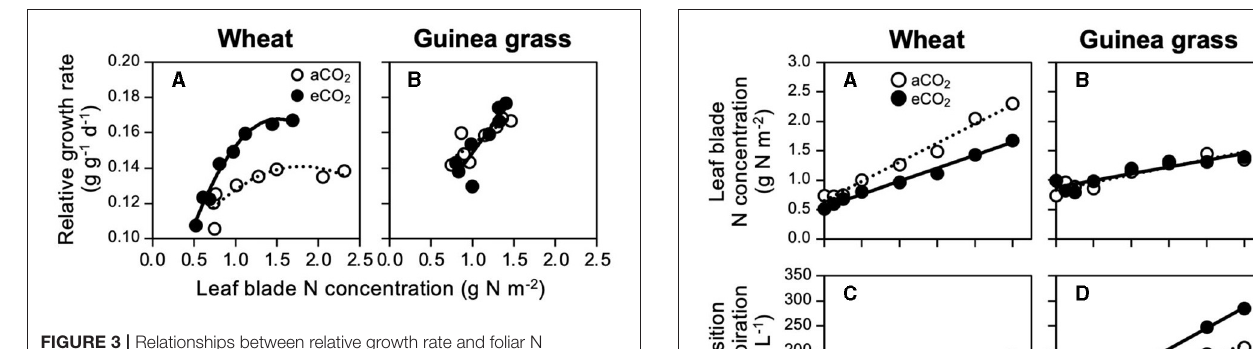
of the five plant species used, at least under the conditions of this